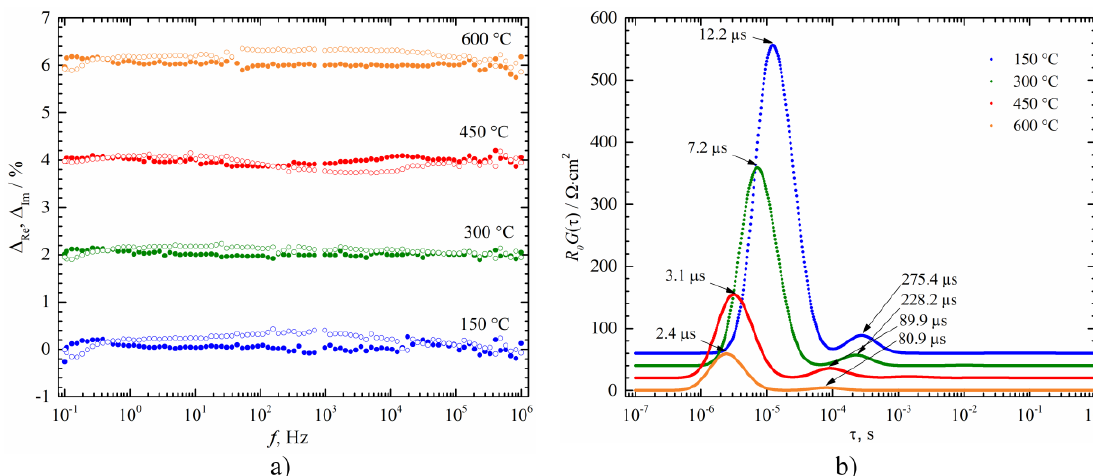
Figure 5. ( a ) Relative residuals of the Kramers–Kronig (KK) test (closed symbols: Δ re , open symbols: Δ im . The data have been offset by steps of 2%) and ( b ) the DRFT’s plots for SDC thin films deposited by evaporating powder of 201.3 m 2 /g specific surface area and with a 0.4 nm/s deposition rate.